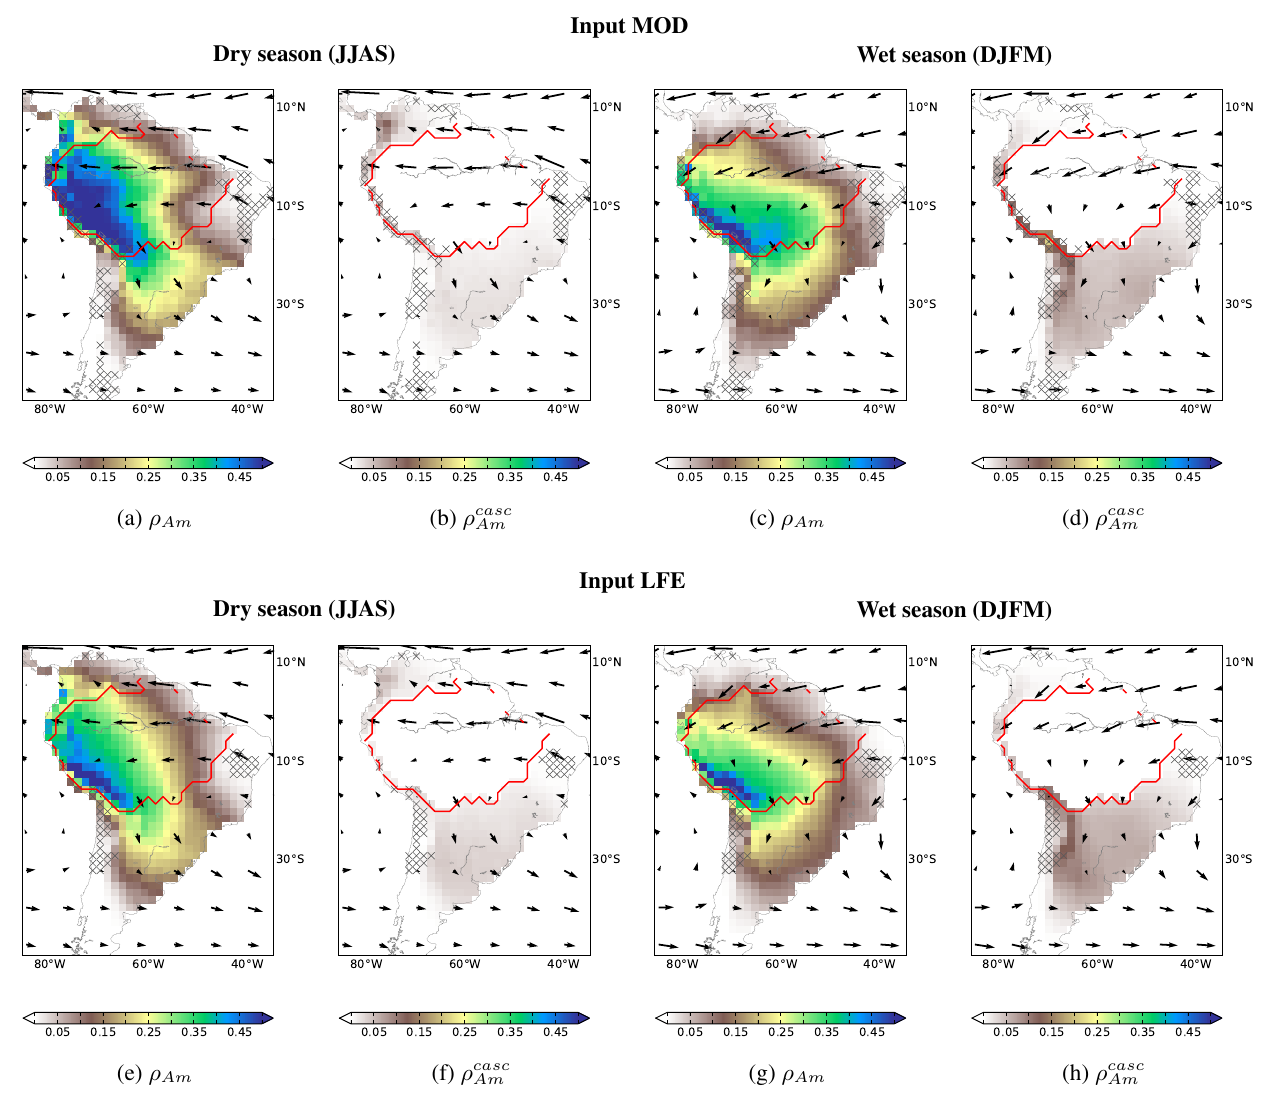
Figure 8. Fraction of precipitation that originates from the Amazon basin (defined by the red boundaries) through DMR ( ρ Am , a , c , e and g ) and CMR ( ρ casc , b , d , f and h ). Considered together, ρ Am and ρ casc show sink regions of evapotranspiration from the La Plata basin. Results are obtained using the input MOD (upper row) and input LFE (lower row) (see Table 1) and are given for the dry season (left) and the wet season (right).